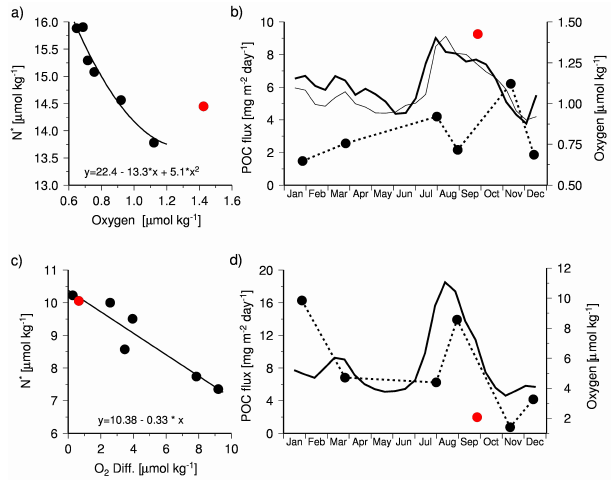
Figure 5. NO − deficits expressed as N ∗ versus oxygen concen- 3 trations in the SNM (a) . Monthly mean organic carbon fluxes meas- ured by sediment traps at a water depth of 3000m in the central (bold line) and eastern Arabian Sea (thin line) (Haake et al., 1993; Rixen et al., 2005), as well as the mean oxygen concentrations in the SNM measured during the US JGOFS cruises in 1995 and the cruise M74/1b in 2007 (b) . Differences between oxygen concentrations in the SNM and the western Arabian Sea versus N ∗ in the western Arabian Sea (c) . Monthly mean organic carbon fluxes measured by sediment traps at a water depth of 3000m in the western Arabian Sea (bold line; Haake et al., 1993; Rixen et al., 2005) and the mean oxygen concentrations in the western Arabian Sea measured during the U.S. JGOFS cruises in 1995 and the cruise M74/1b in 2007 (d) . Black circles indicate the US JGOFS data and the red circle indicates the one derived from the cruise M74/1b. The oxygen and N ∗ data are given in Table